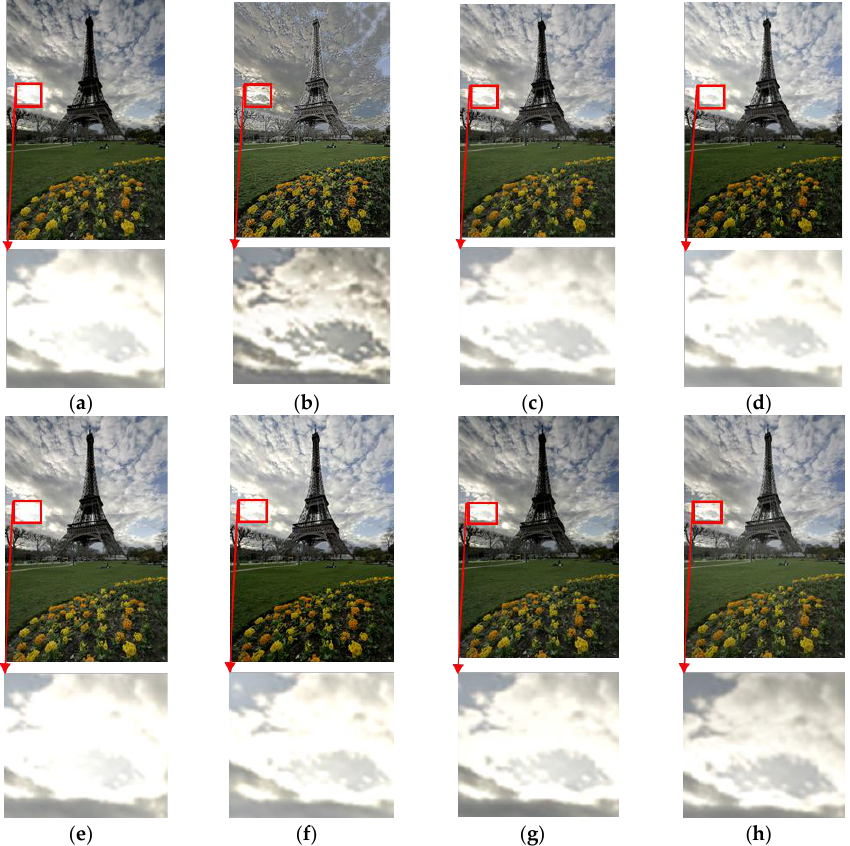
Figure 8. Fusion results for Figure 4d. ( a ) Mertens et al.’s method [ 16 ] . ( b ) Shen et al.’s method [ 21 ] . ( c ) Li et al.’s method [ 22 ] . ( d ) Ma et al.’s method [ 24 ] . ( e ) Hayat et al.’s method [ 25 ] . ( f ) Qi et al.’s method [ 27 ] . ( g ) Huang et al.’s method [ 28 ] . ( h ) The proposed method.